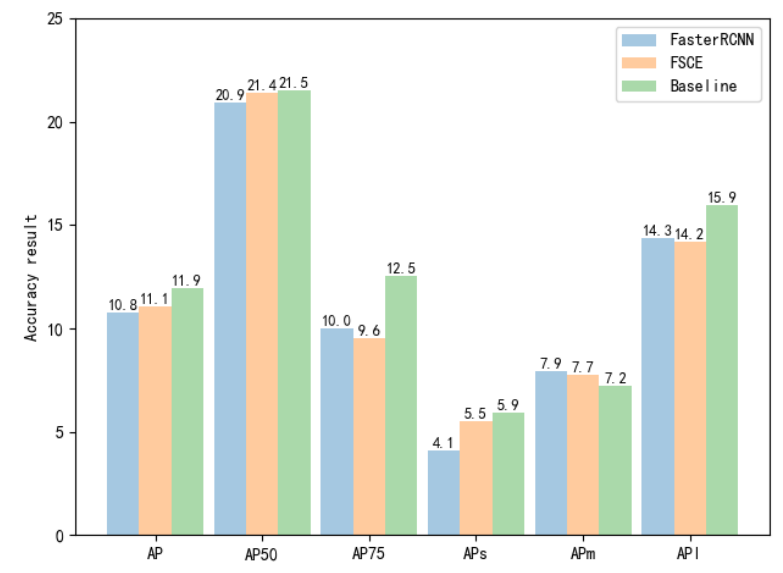
Figure 8. The detection result of single-branch and two-branch object detection models.